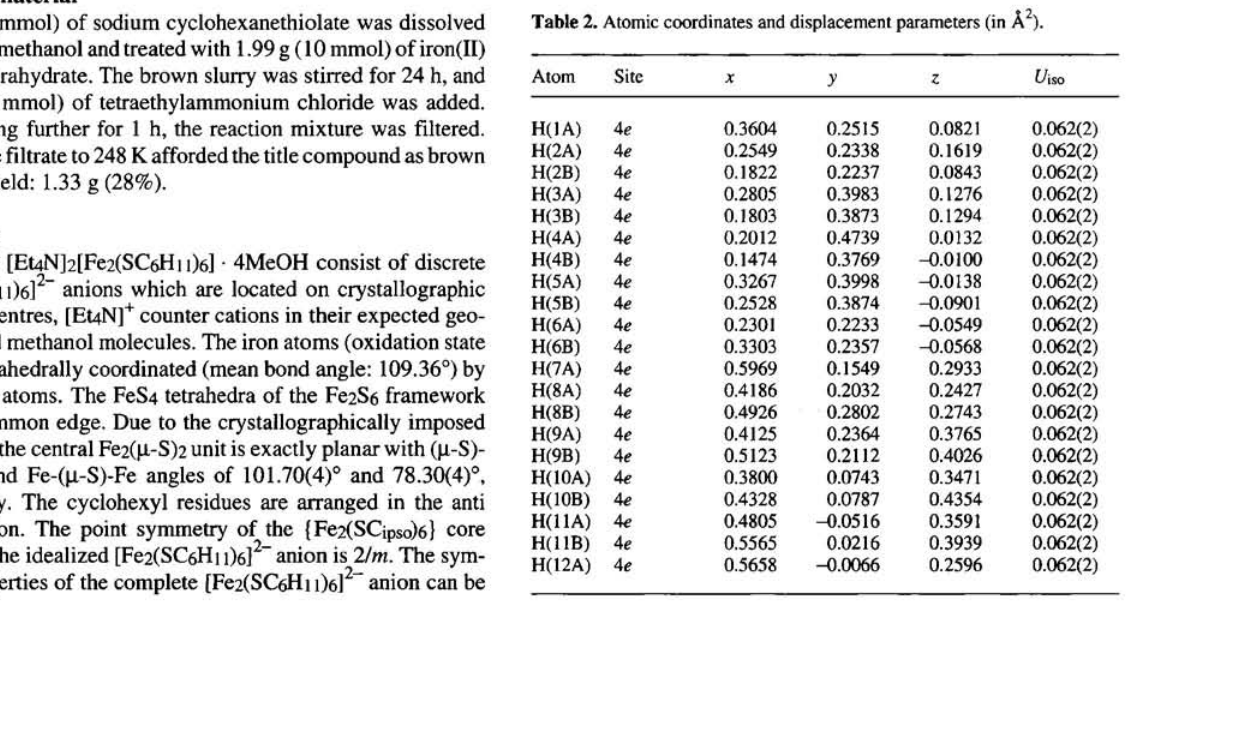
Table 2. Atomic coordinates and displacement parameters (in Â 2